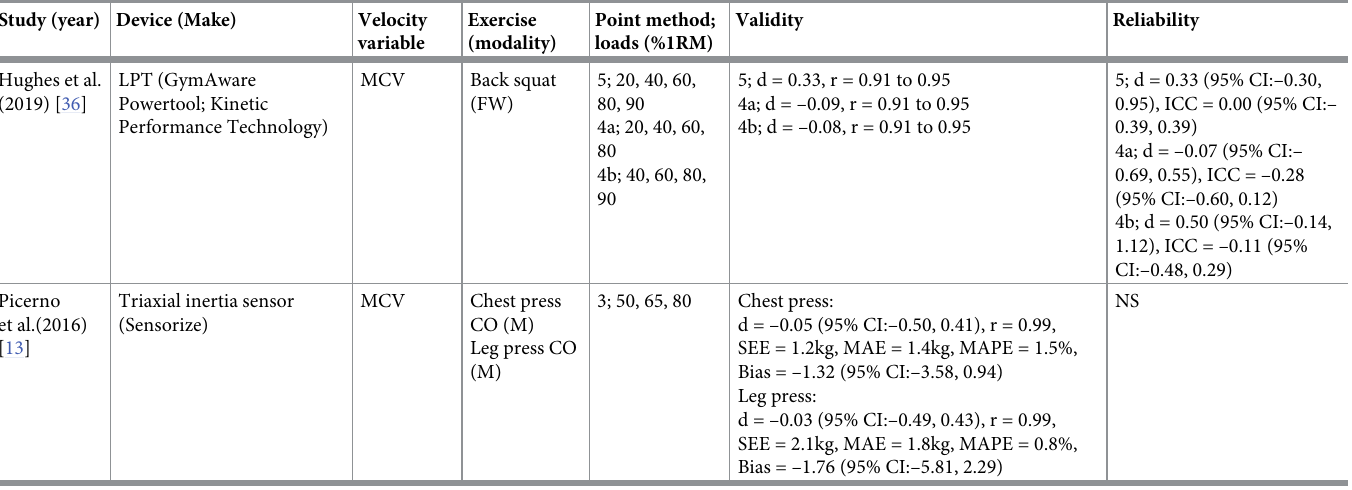
Table 6. Summary of results utilising the force velocity prediction